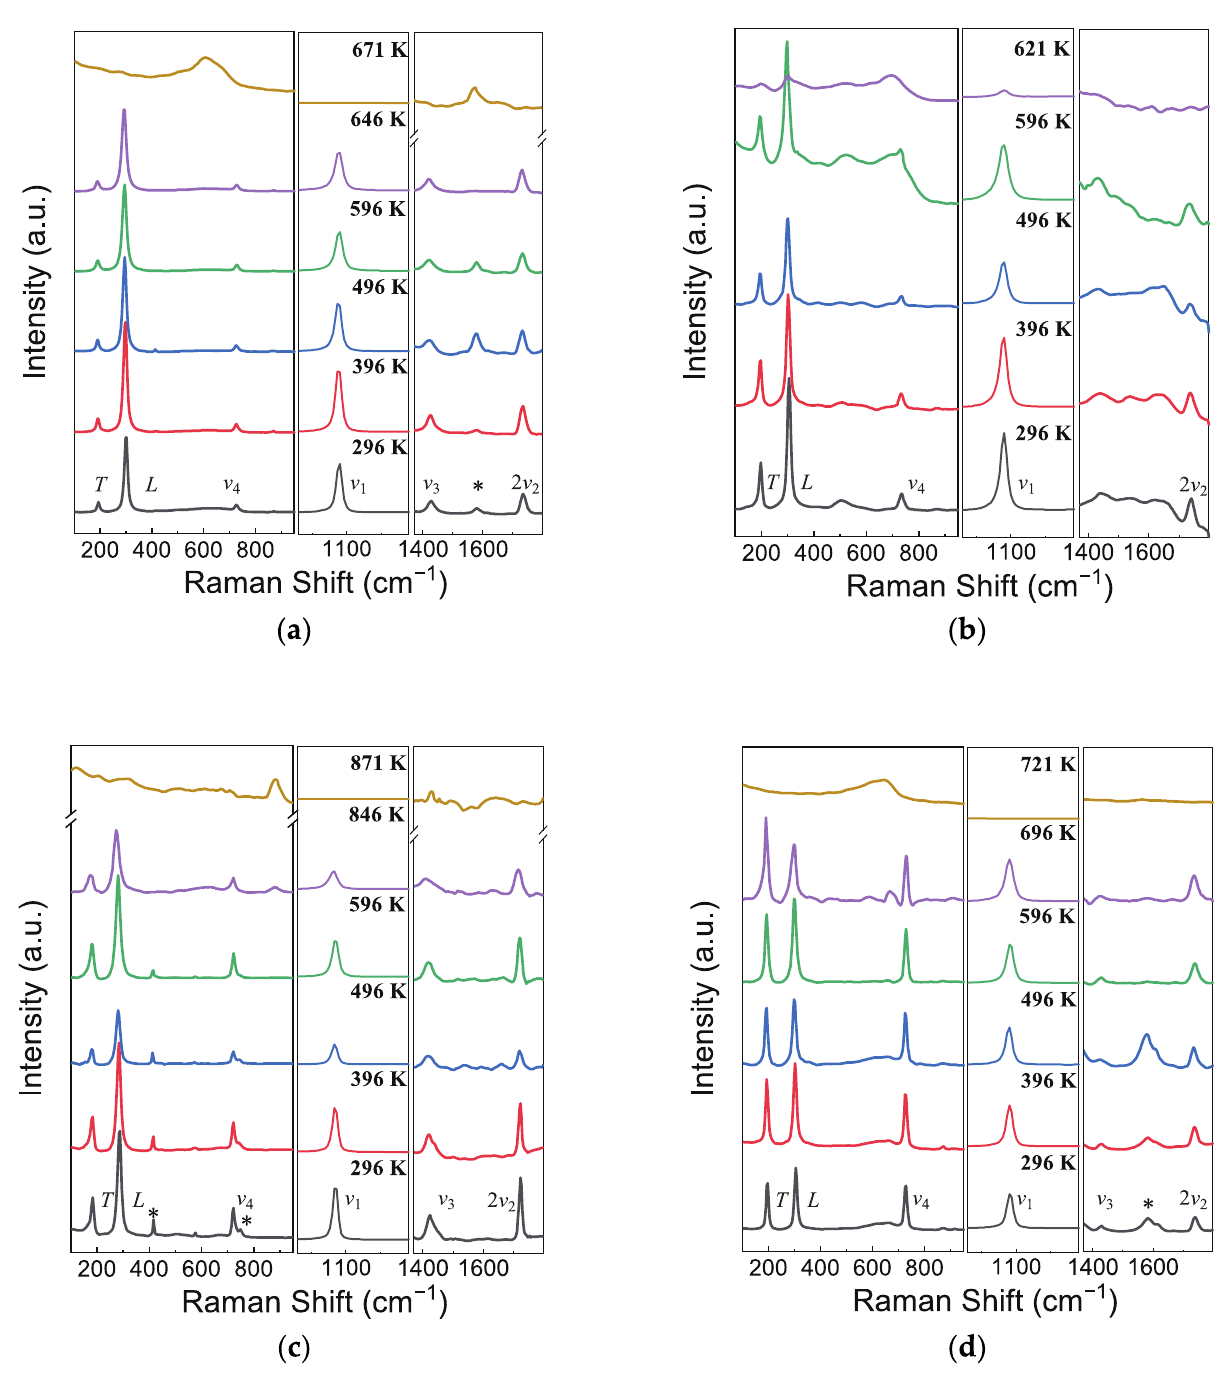
Figure 3. Representative Raman spectra of ( a ) MFM, ( b ) MF, ( c ) FM, and ( d ) MM at high temperature. The asterisks (*) symbolize the unassigned Raman peaks.